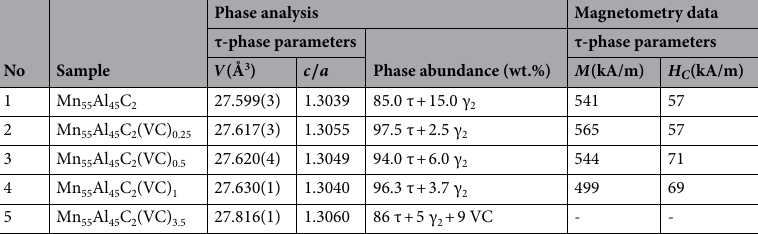
Phase analysis Magnetometry data τ-phase No Sample